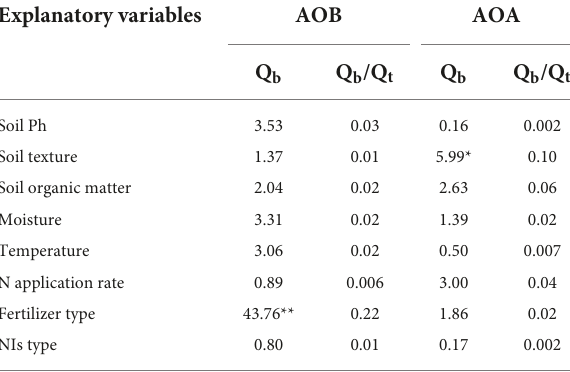
TABLE 2 Between-group heterogeneity (Q b ) illustrating the effects of NIs additions on ammonia oxidizer across categorical modifiers. Explanatory